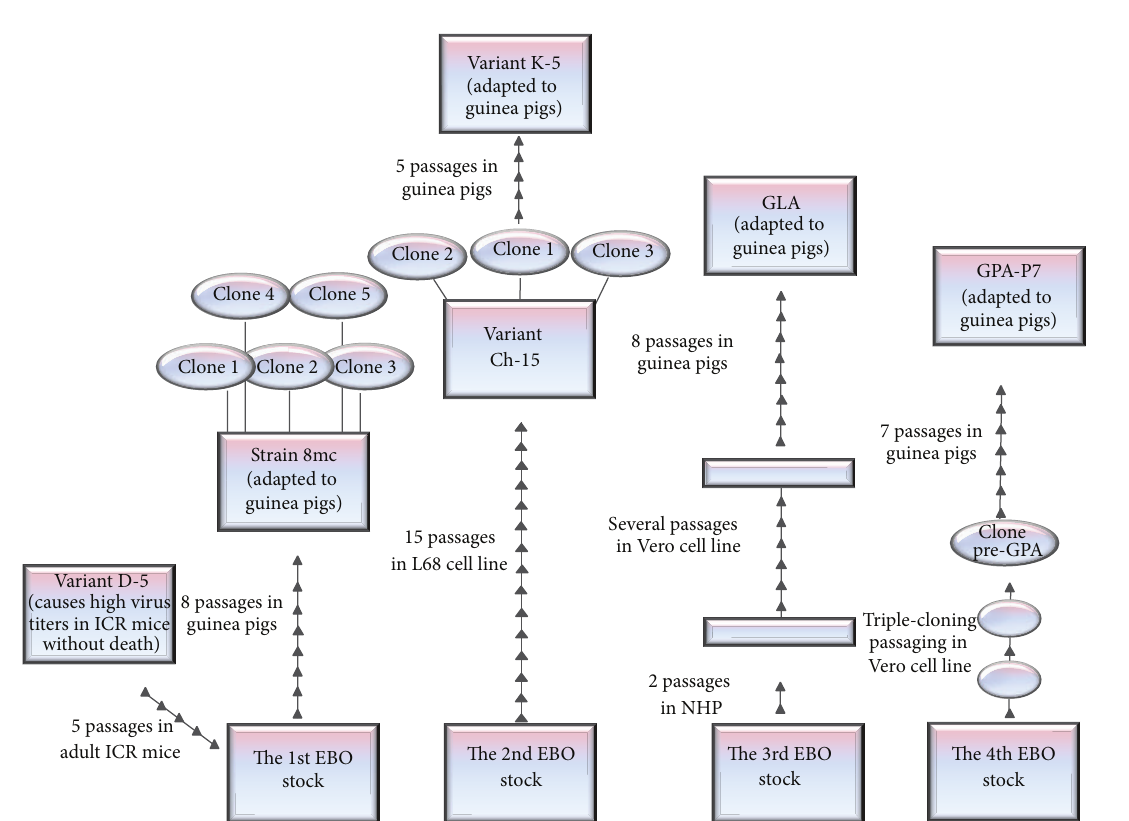
Figure 1: Adaptation series of wild-type Mayinga strain EBOV to guinea pigs and mice resulting in the establishment of 8mc, K-5, GLA, and GPA-P7 lethal guinea pig-adapted virus variants and a paradoxical high-titer, avirulent mouse-adapted virus variant